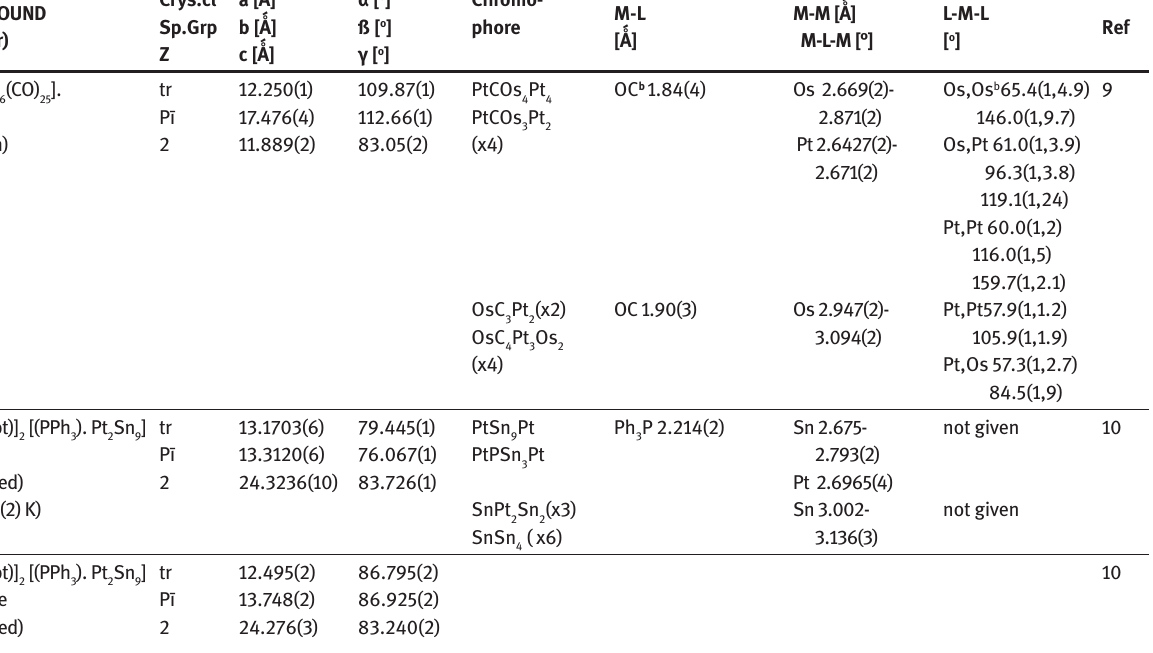
Table 1: Crystallographic and structural data for heteroudecanuclear platinum clusters a .